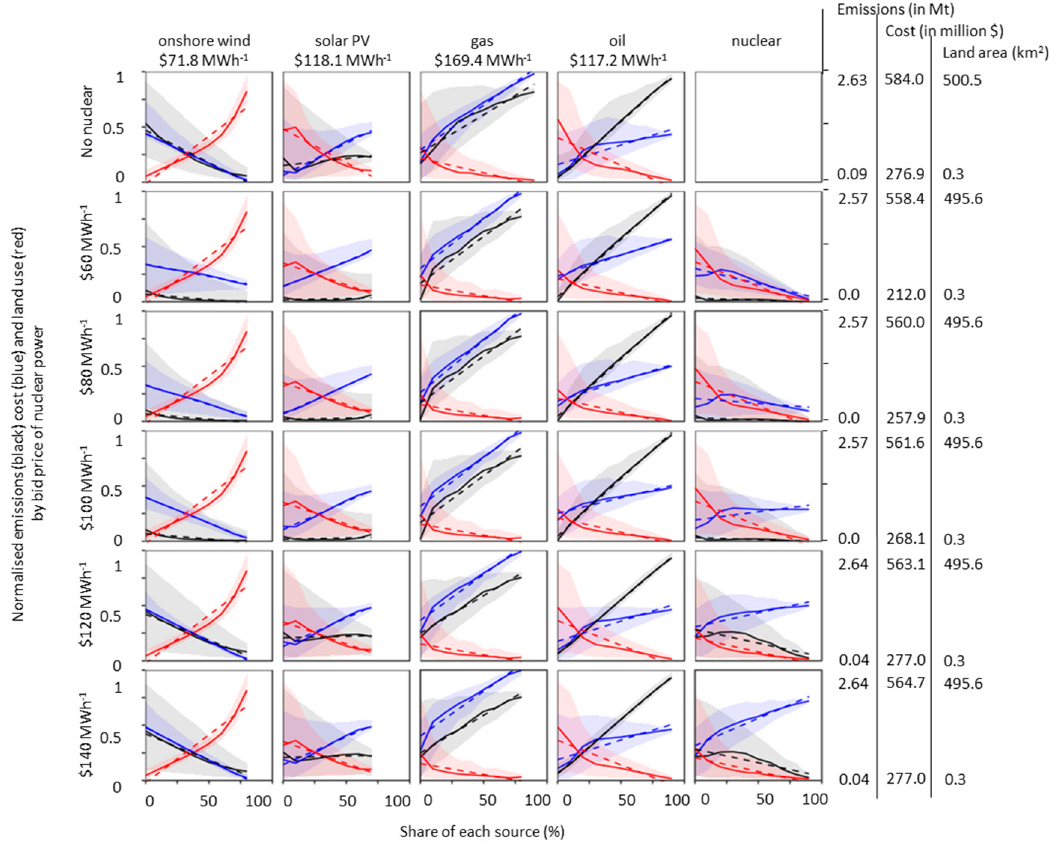
Figure 2. Tenerife example: greenhouse-gas emissions (black) cost (blue) and land use (red) and its median for each section (continuous) based on incremental 5% changes in the share by each source of total annual generation, along with regression graphs (dotted) showing the share of each electricity source. Each plot is redrawn from the same output to display the changes by share of each source.